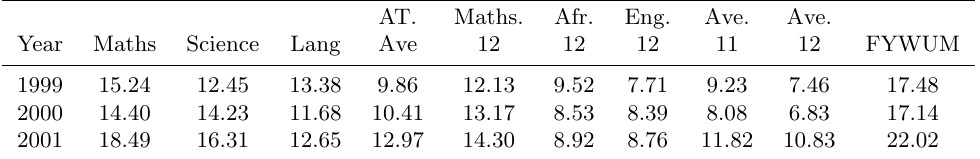
Table 4: Standard deviations of the variables of the Test Battery 1 data set for the 1999, 2000 and 2001 intake groups.